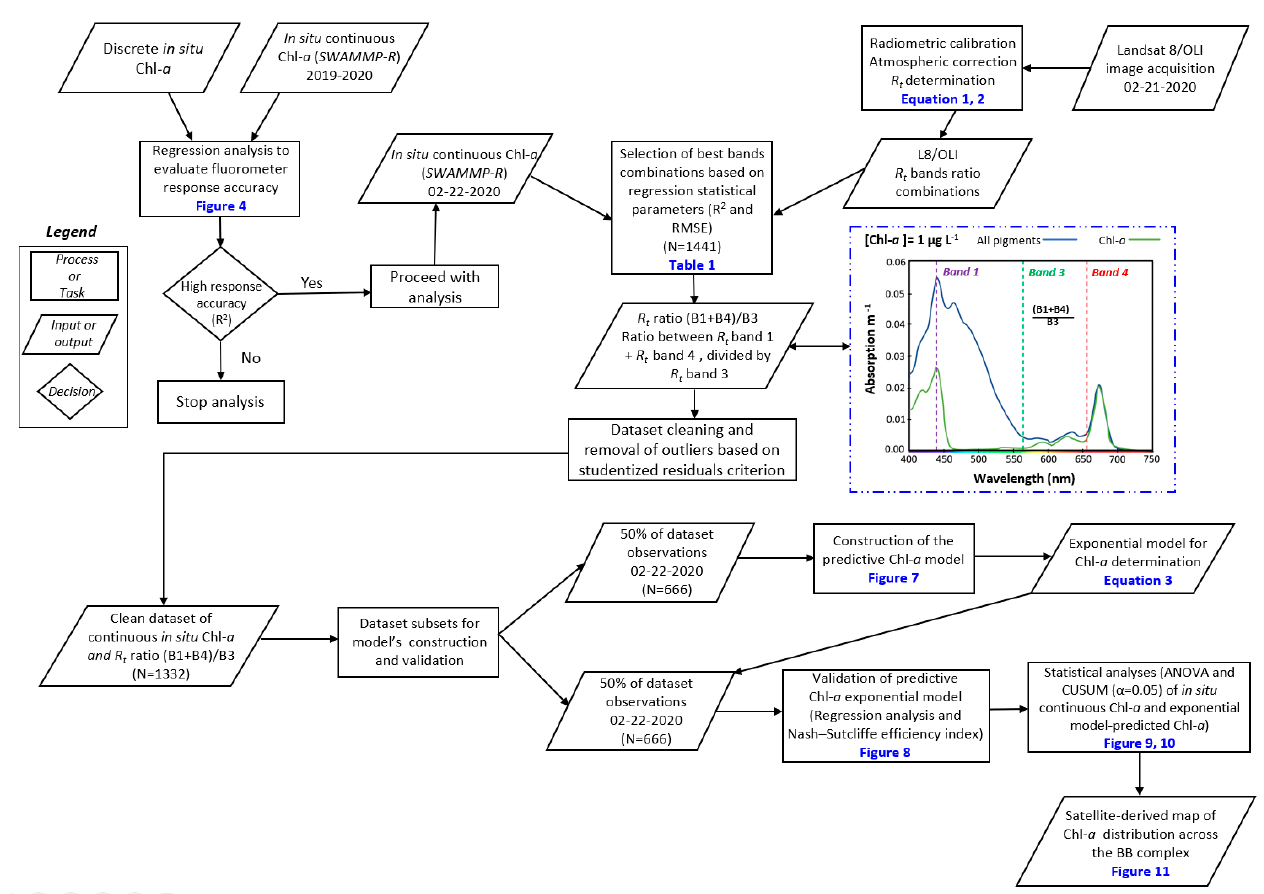
Figure 2. Flow chart summarizing the methods used in the algorithm calculations. SWAMMP-R : S patially explicit WA ter Monitoring system to inform M anagement P riorities and R isks; L8/OLI: Landsat 8/OLI satellite; Chl- a : chlorophyll a ; R t ratio (B1 + B4)/B3: remote sensing reflectance ratio between band 1, band 4 and band 3; R 2 : coefficient of determination; RMSE: root mean square error; BB complex: Barataria Basin. The blue-dotted line frame shows the wavelength (nm) vs absorption relationship used to estimate the R t ratio value; the spectral signature was obtained using a Chl- a value = 1 µg L − 1 [87].